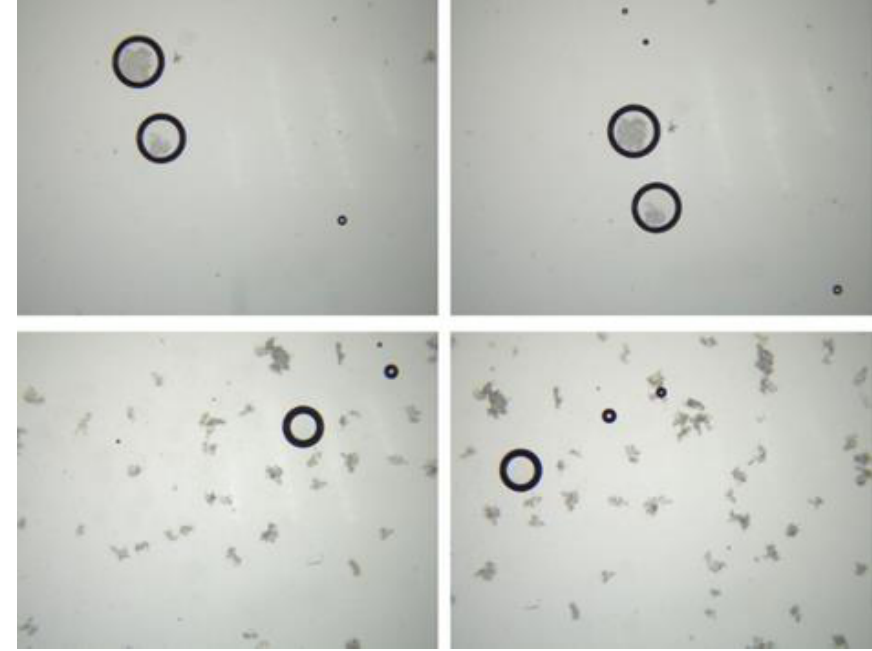
Figure 3. Micrographs of the CFEO-Ms.